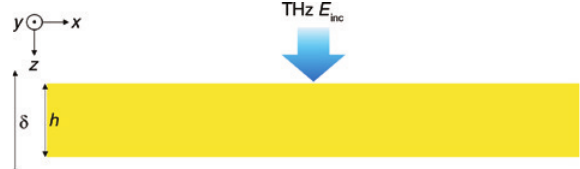
Figure 4: Metallic thin film with a thickness less than the THz skin depth is irradiated by THz